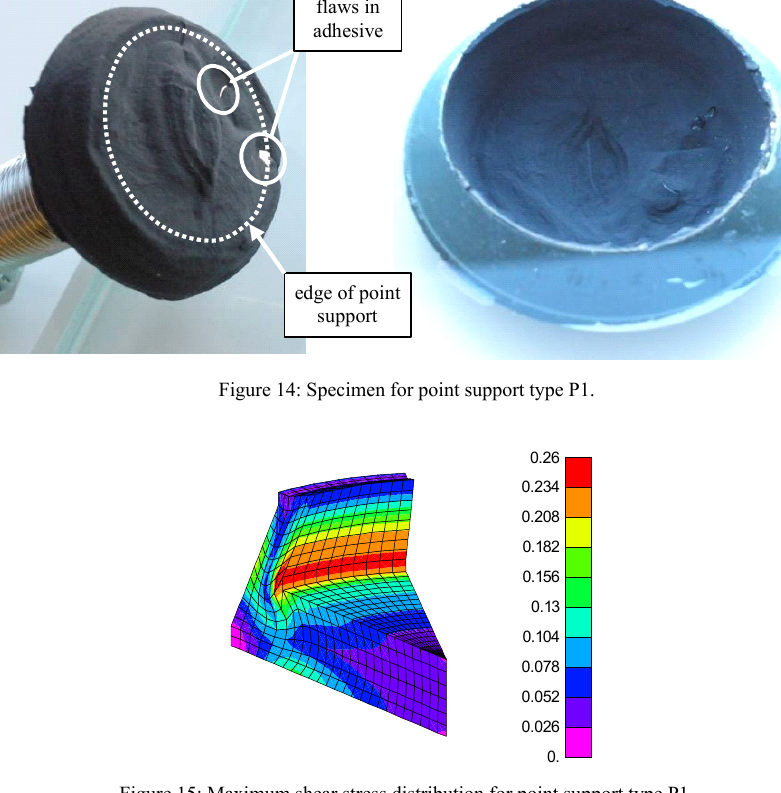
Figure 15: Maximum shear stress distribution for point support type